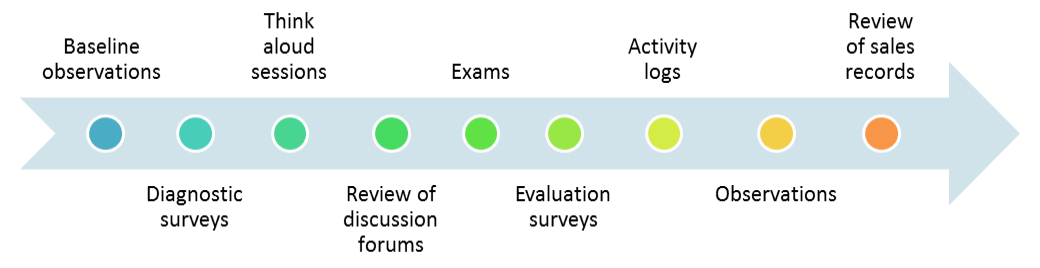
Figure 1 . Timeline of data